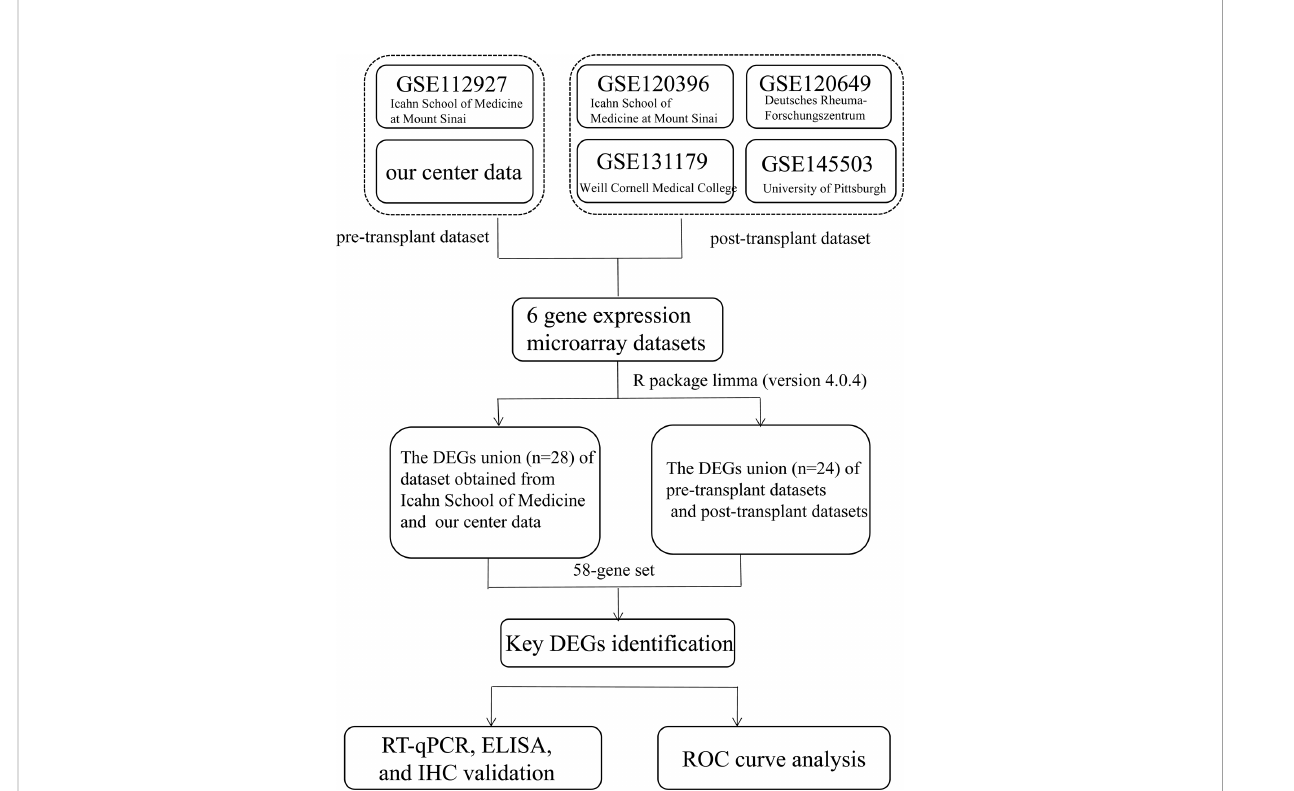
FIGURE 1 Flowchart depicting the overall study design. A 58-gene dataset was aligned with those expressed by 64 immune cells in xCell and the key genes were identi fi ed. Fifteen key DEGs were identi fi ed for further validation (KIF3B, FH, EIF4G1, SMARCD1, ITGAL, HNRNPUL1, MAP4K5,